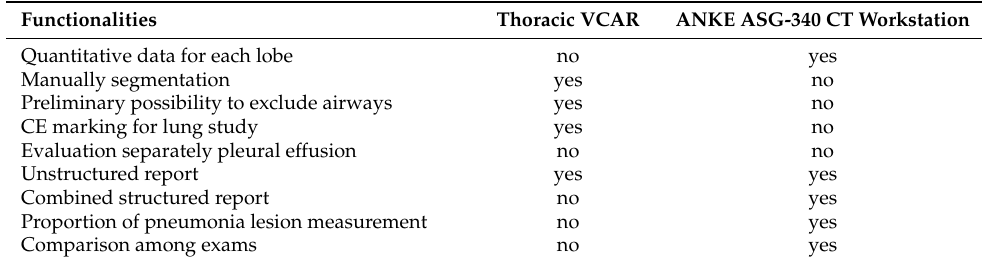
Table 1. Description of computed based tool